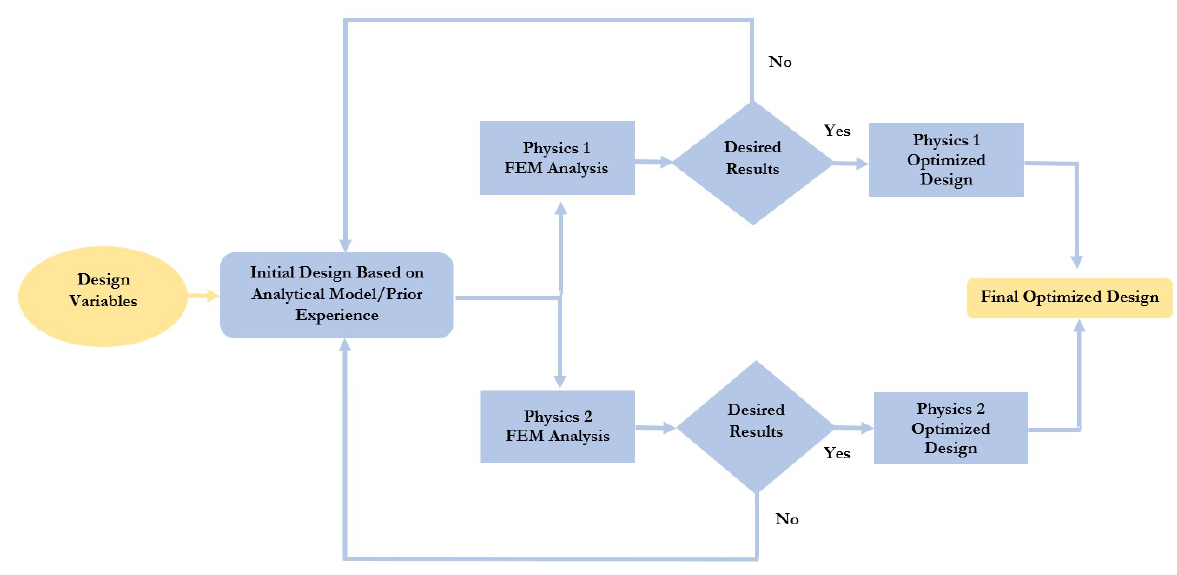
Figure 1. Traditional design optimization approach for MEMS